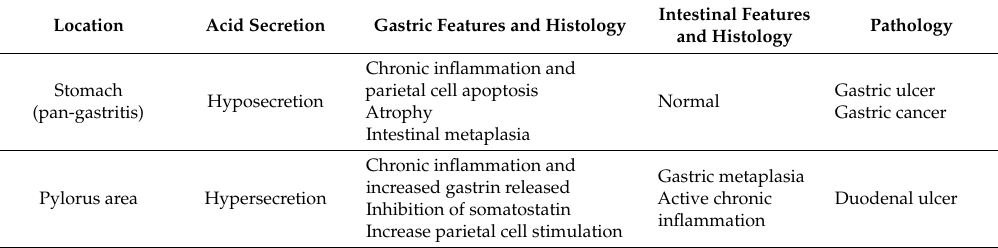
Table 4. Features associated with H. pylori infections and subsequent inflammation located in different parts of the gastrointestinal